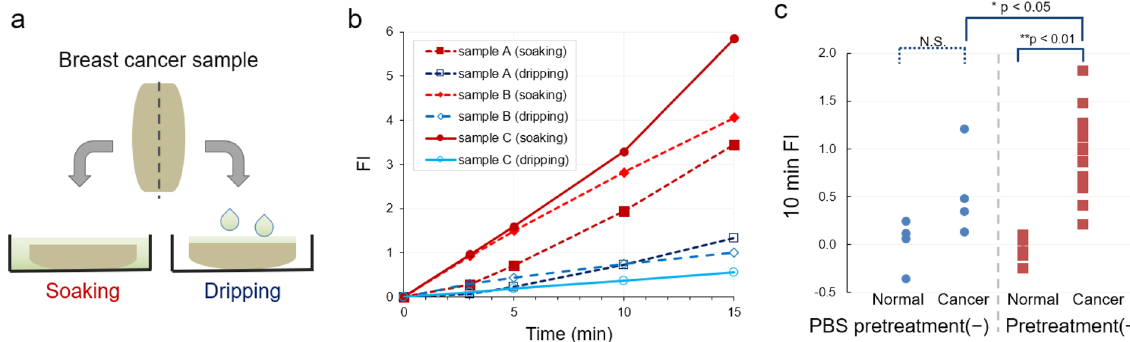
Figure 1. Comparison of the fluorescence measurement procedures tested in this study . (a ) Schematic diagram of the testing method used to compare the new soaking and the previous dripping procedures. ( b ) Three representative examples showing differences between the new soaking and the previous dripping procedures. Filled symbols with red lines indicate the FIs of samples that were soaked in the probe solution. Open symbols with blue or cyan lines indicate the FIs of samples onto which sample solutions were dripped before the measurements. ( c ) FIs with or without pre-soaking in PBS solution for > 0.5 min. p -values were calculated using the Steel–Dwass test. N.S. indicates not significant ( p >